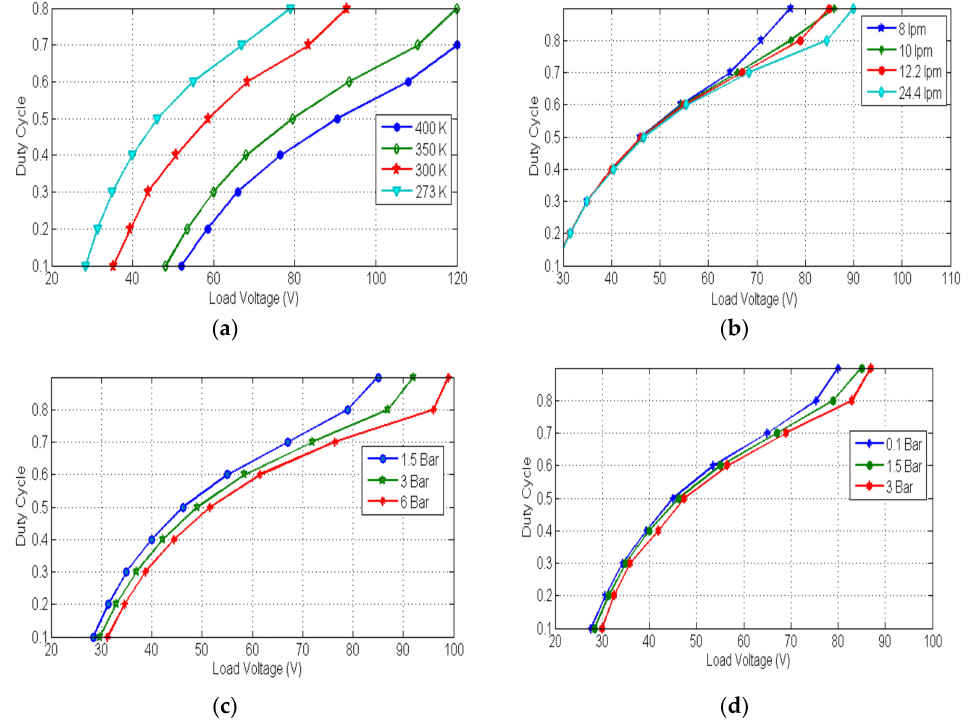
Figure 8. Duty cycle for: ( a ) different temperature values, ( b ) different values of the fuel flow rate, ( c ) different values of the fuel supply pressure, ( d ) different values of the air supply pressure.